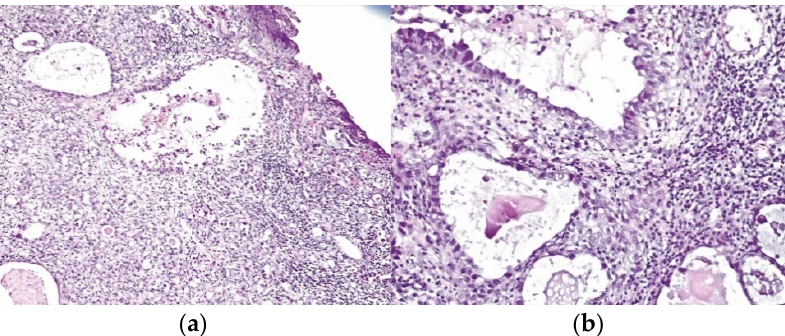
Figure 1. ( a,b ) (detail)—H&E stain—conization specimen—atypical mesonephric hyperplasia with a malignant transformation zone—mesonephric adenocarcinoma with moderate cell pleomorphism, moderate mitotic activity, without invasion of the lymphovascular space.